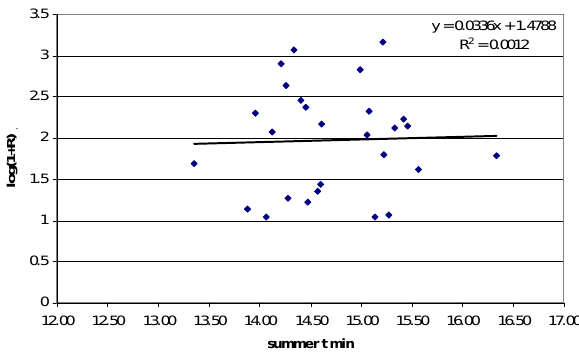
Fig. 4. Correlation estimated between hail damage and minimum summer temperature, at a 95% of significant level, for Peninsular Spain data as a single set and all crops. Graph shows minimum summer temperature at the x-axis (summer t min) and transformed hail damage index (log(1+ R )) at the y-axis.